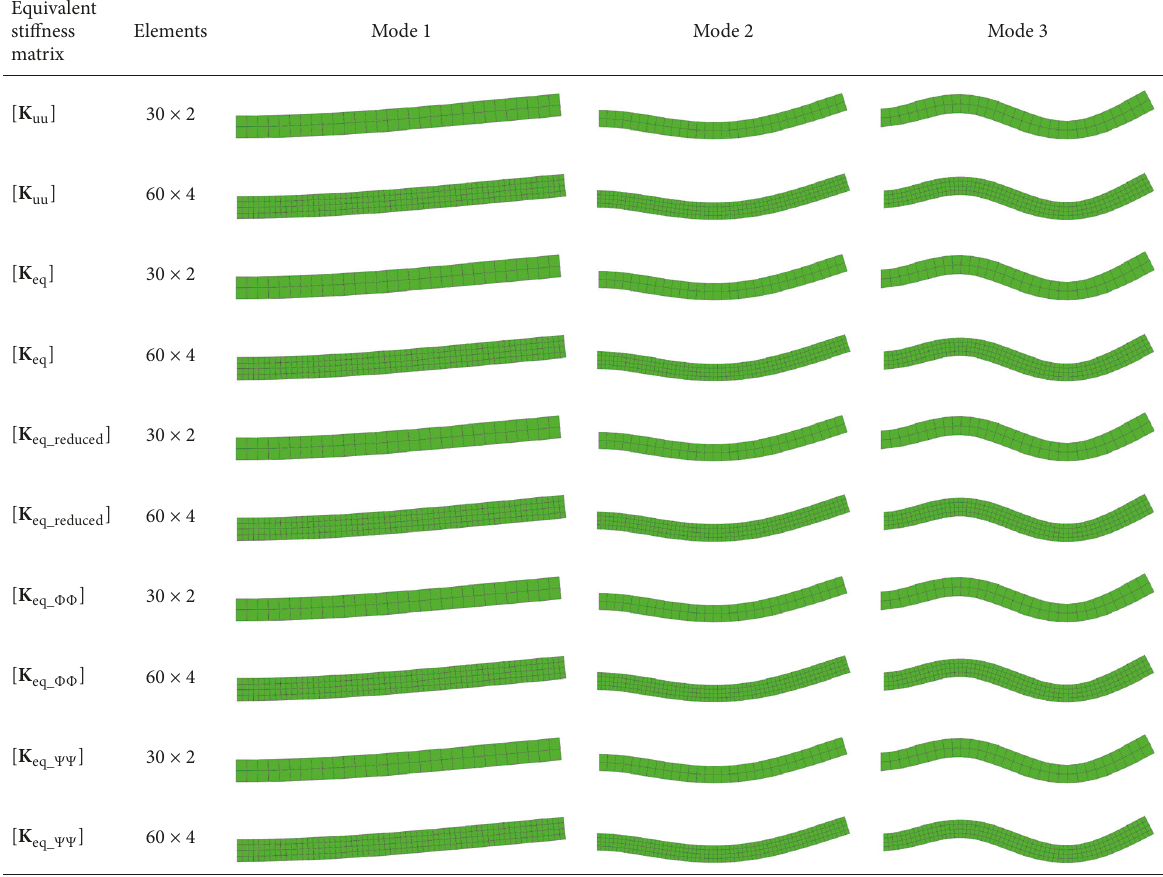
Figure 8: Domain discretization using four-node extremely irregular